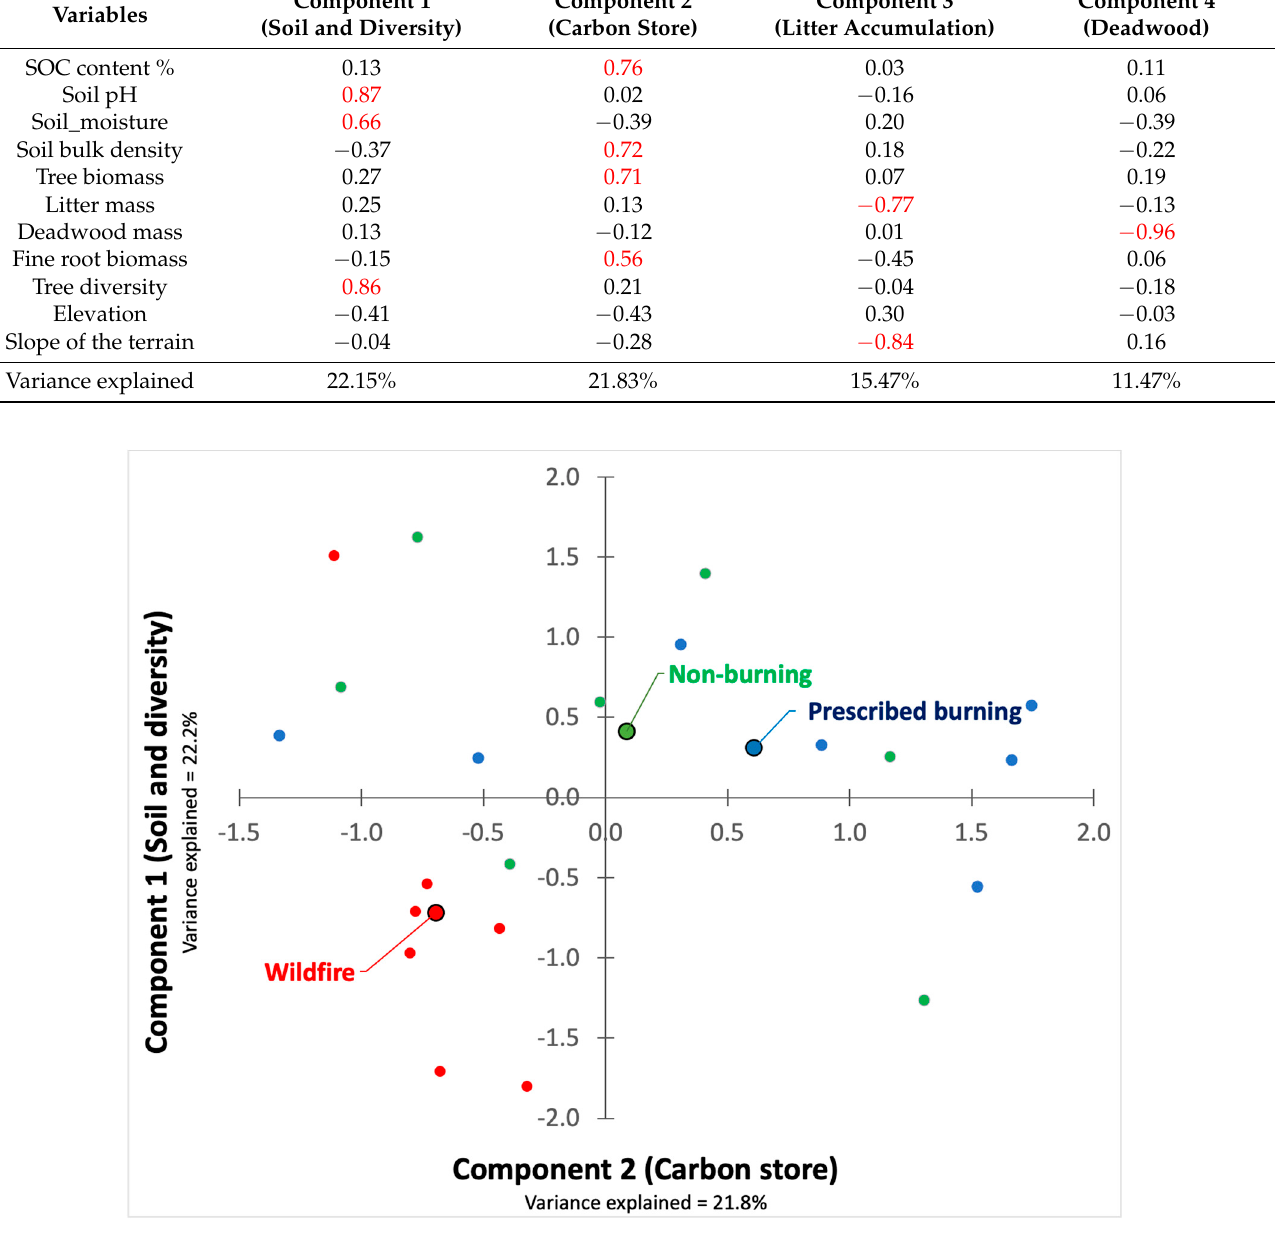
Figure 7. Biplot from principal component analysis taking into account the first two components that explained the major portion of the variance. Blue circles represent prescribed burning sites, green non-burning sites, red wildfire